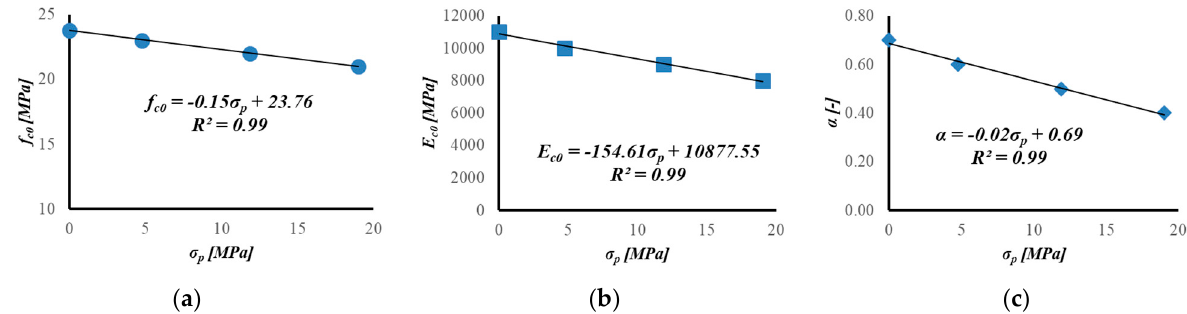
Figure 9. Analytical interpretation of the pre-load effect: f c0 ( a ); E c ( b ); and α ( c ).